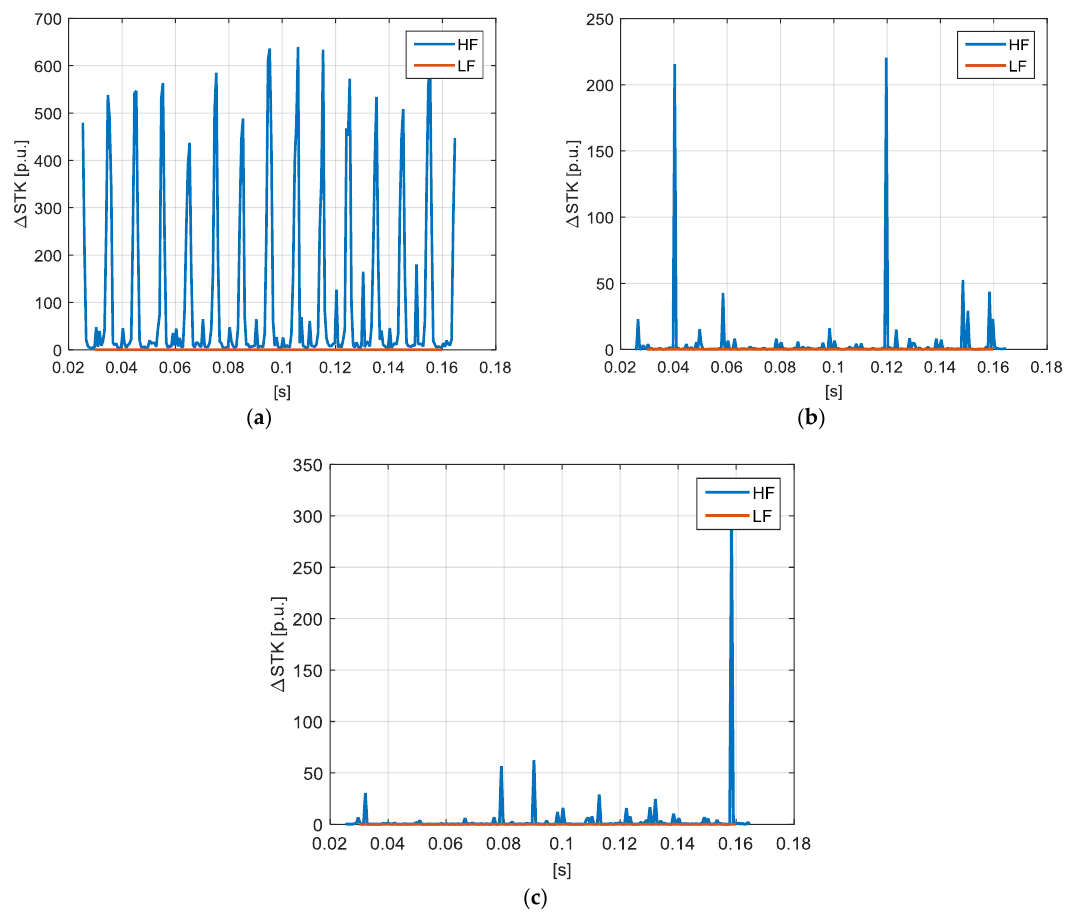
Figure 50. Case study 4: Δ STK at low-frequency (0 ÷ 2 kHz, red line) and at high-frequency (2 ÷ 150 kHz, blue line) obtained for ( a ) one lamp, ( b ) ten lamps, and ( c ) forty-eight lamps.